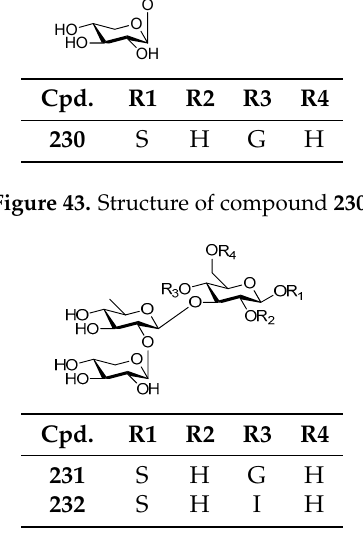
Figure 44. Structures of compounds 231 – 232 .